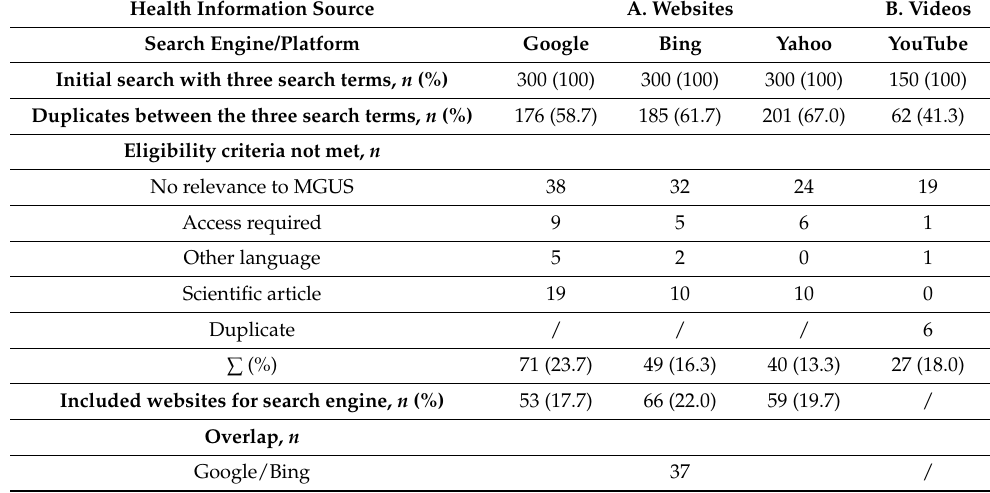
Table 1. Search results for websites and